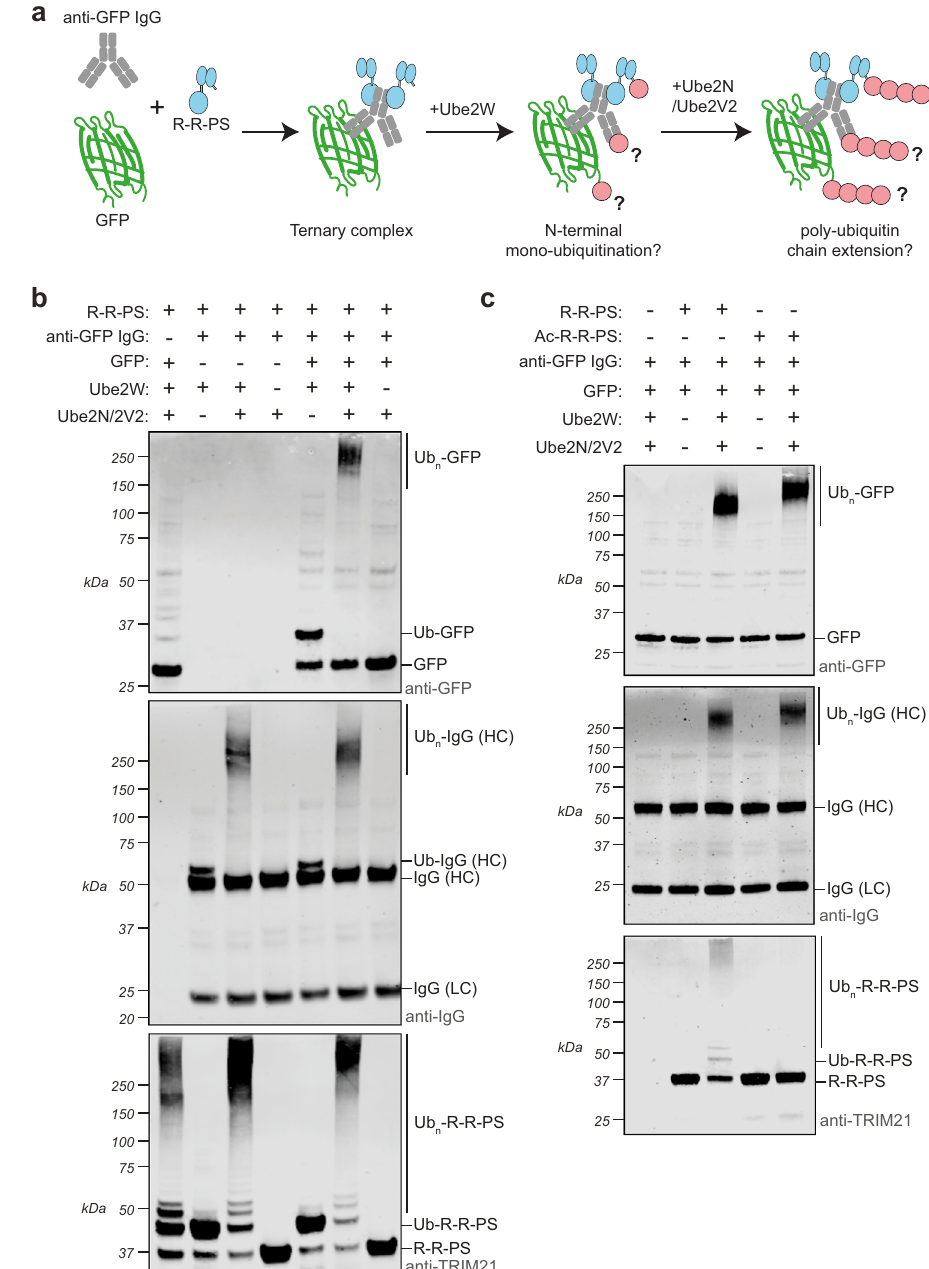
Fig. 4 | In vitro Trim-Away reveals direct substrate ubiquitination. a Schematic showinganinvitroubiquitinationreactioninwhichligase(R-R-PS),substrate(GFP) andanti-GFPantibodyareincubatedtogetherwithE2enzymesUbe2WandUbe2N/ Ube2V2 to promote either mono- or polyubiquitination. b Western blot of experimentdescribedin( a ).ToppanelisblottedforGFP,middlepanelforIgGand lowerpanelforTRIM21.DependingontheE2spresent,monoubiquitinatedspecies or a higher molecular weight smear indicative of polyubiquitin are observed.